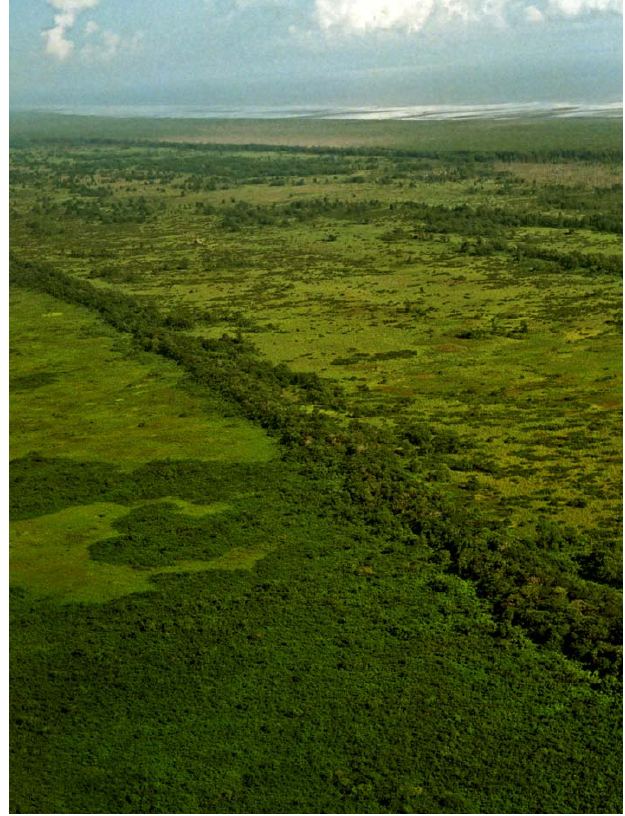
Figure 2. Old coastal plain of French Guiana showing an elongated chenier between